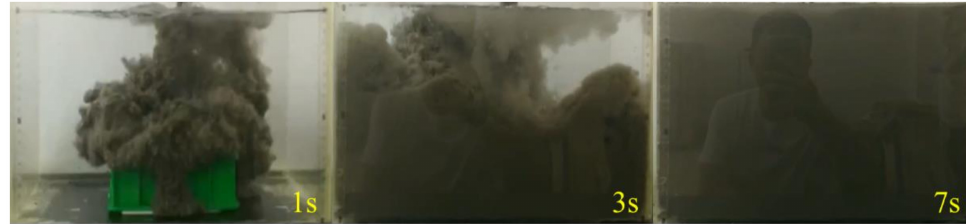
Figure 3. Diffusion process of CSG in